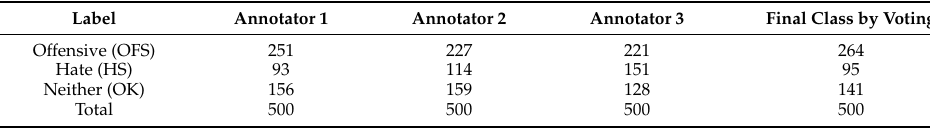
Table 4. Annotation result of common posts and comments.